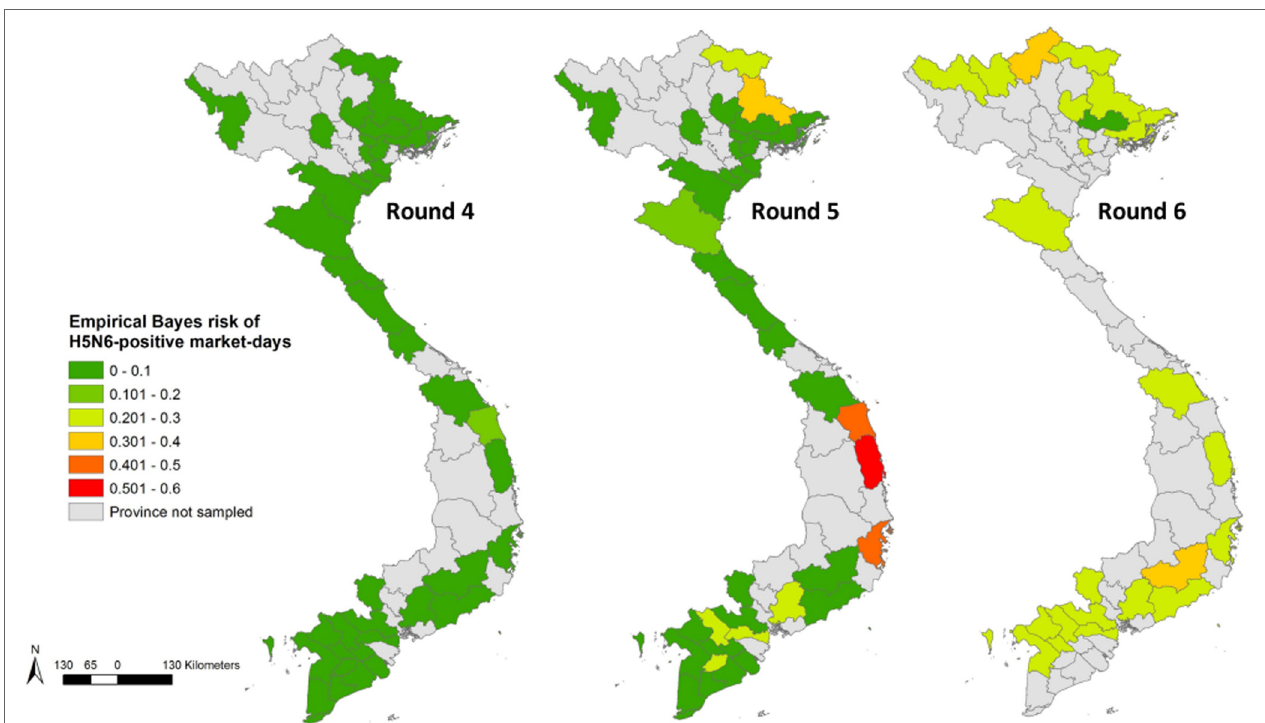
FigUre 4 | Province-level empirical Bayes risk of highly pathogenic avian influenza H5N6 in Vietnam (Rounds